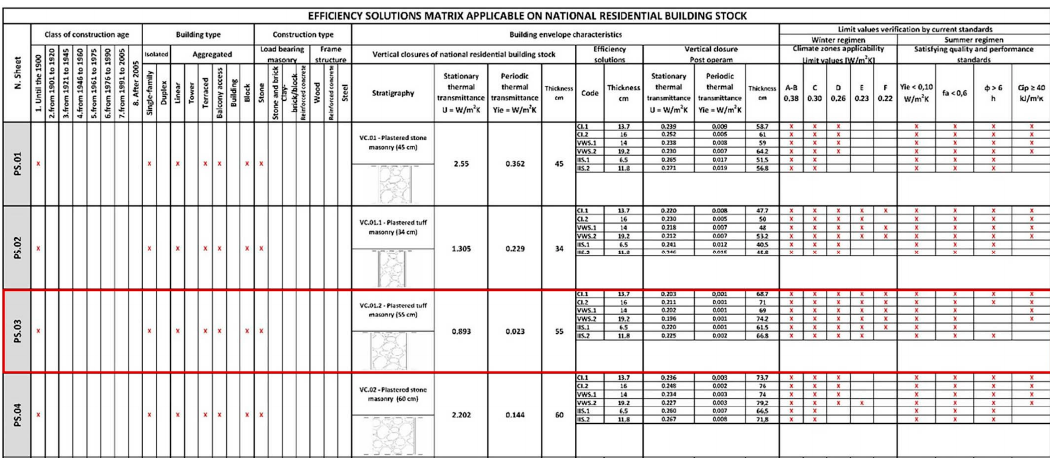
Figure 7. Matrix of efficiency solutions applicable to the national building